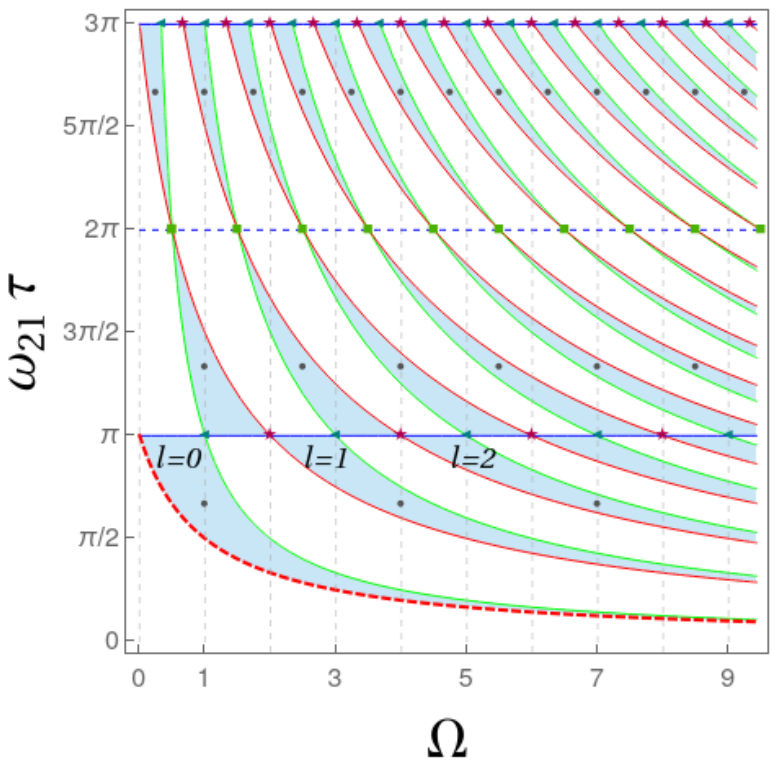
Figure 1. Diagram ω 21 τ vs. Ω , with Ω = ω 32 / ω 21 . The coefficients { r 1 , r 2 , r 3 } giving rise to states (1) that reach an orthogonal state at time τ are represented by points in the diagram for the corresponding values of ω 21 τ and Ω . Blue-shaded regions represent { r i } of Family II, satisfying Equation (8). These regions are bordered by the solutions { r i } pertaining to Family I as follows. For (cid:9) (cid:8) 1 (cid:9) (cid:8) Subfamily I-qubit: , 1 ,0 is identified with solid-blue lines, 0, 1 , 1 with solid-green lines and 2 2 2 2 (cid:8) 1 (cid:9) (cid:8) 1 − r (cid:9) is identified with a star, (cid:8) r , 1 − r (cid:9) with a ,0, 1 with red lines. For Subfamily I-b: , r , 1 , 1 2 2 2 2 2 2 (cid:8) (cid:9) − r , 1 r , 1 left-triangle and with a square. The red-dashed curve indicates the global lower bound 2 2 for the orthogonality